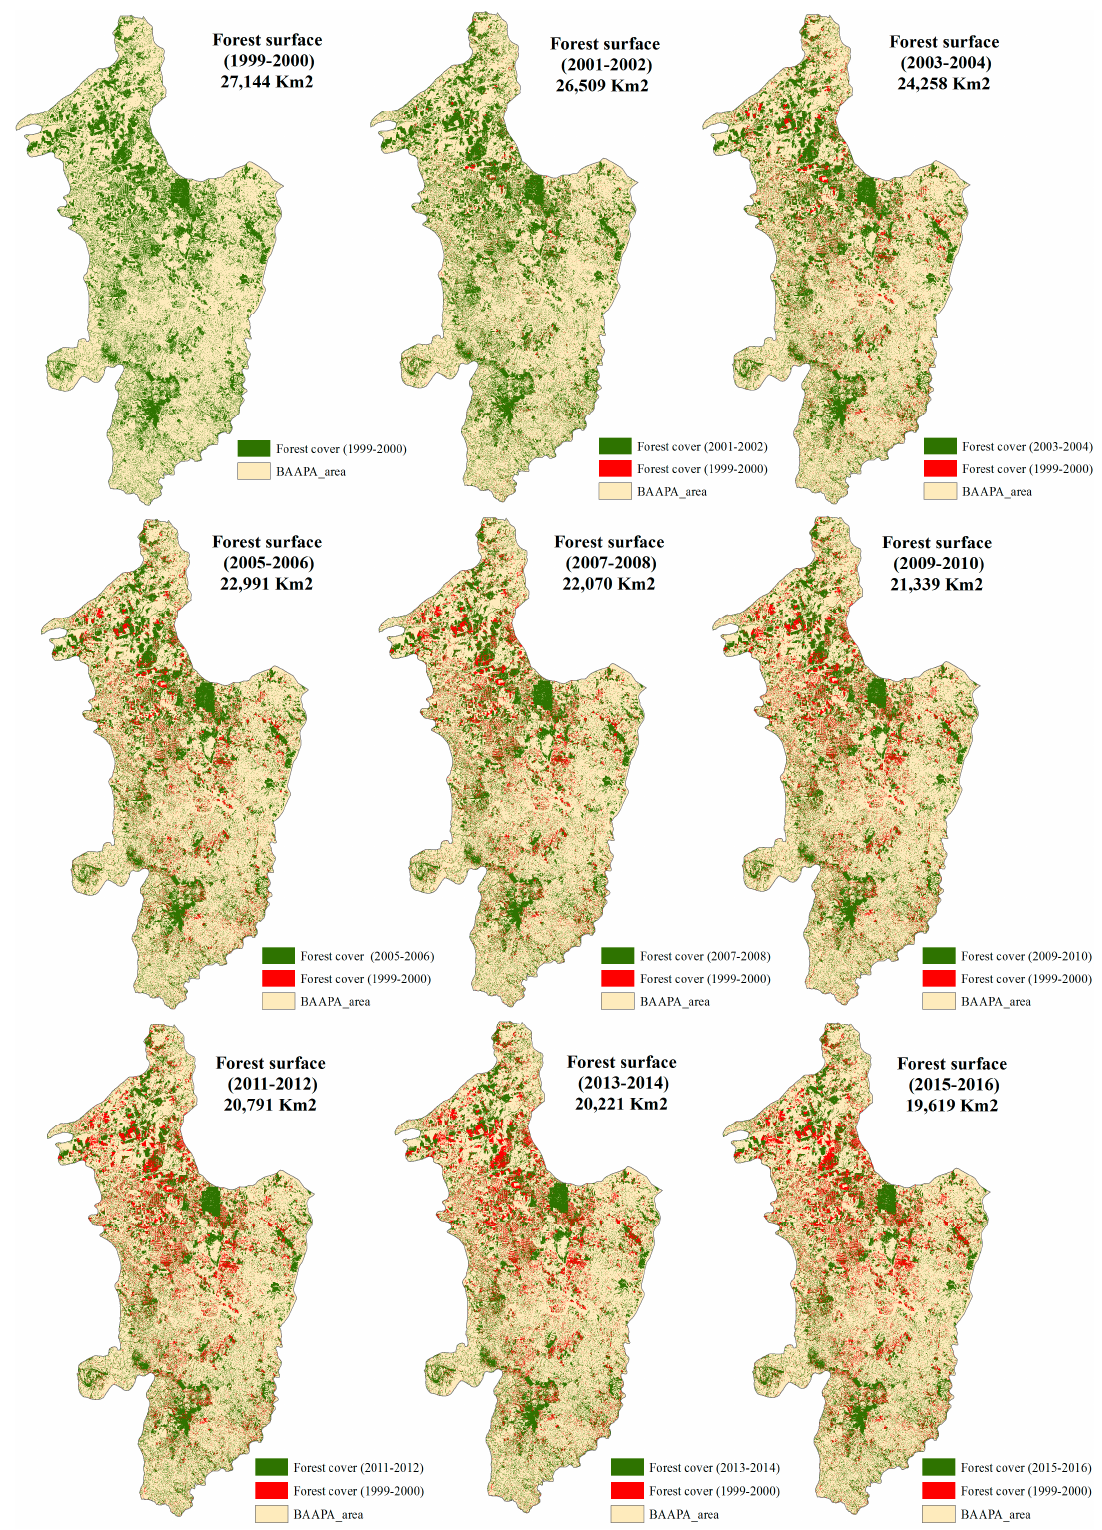
Figure 3. Deforestation results in the BAAPA region between 1999 and 2016.